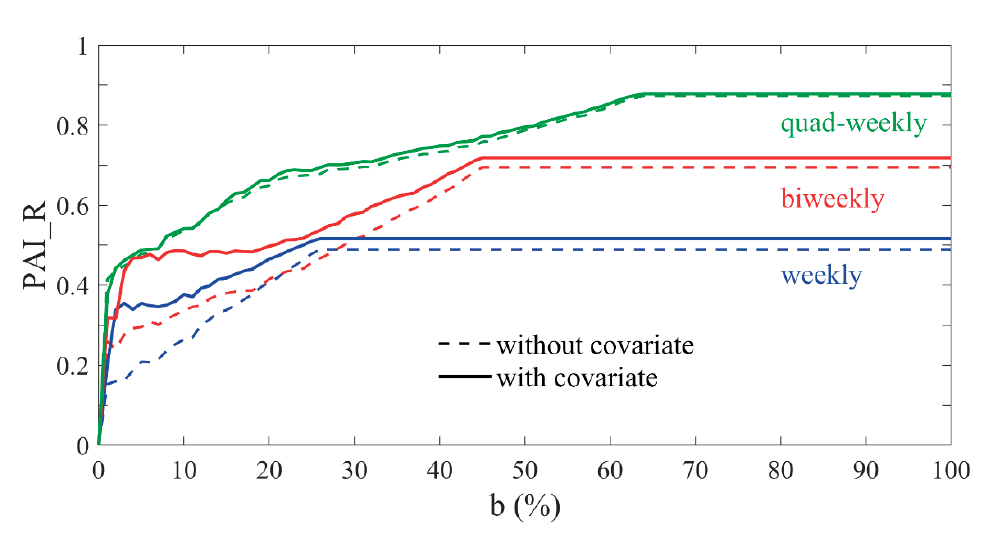
Figure 8. The Predictive Accuracy Index of Raster (PAI R ) curves for the weekly, biweekly, and quad-weekly models.